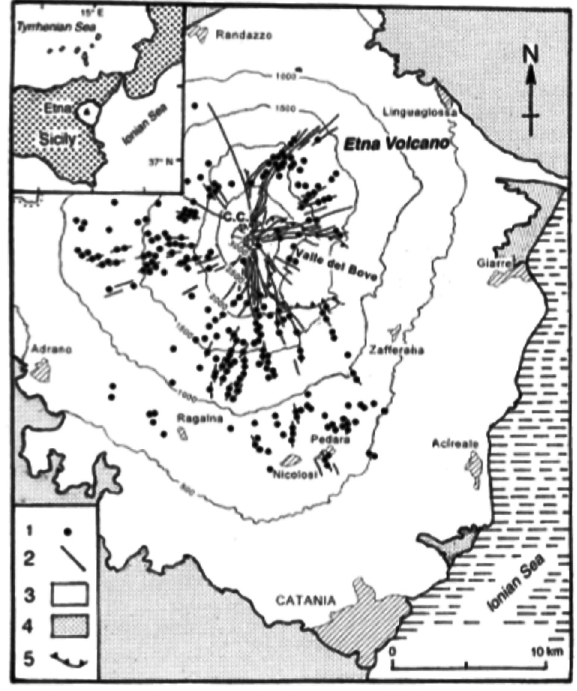
Figure 4. Distribution of parasitic vents on Etna after Azzaro [2004] partly modified: 1) parasitic vents; 2) eruptive fissures; 3) Etna vol- canics; 4) Tertiary-Quaternary sedimentary basement and alluvial deposits; 5) Valle del Bove depression, and C. C. near the summit de- notes the central